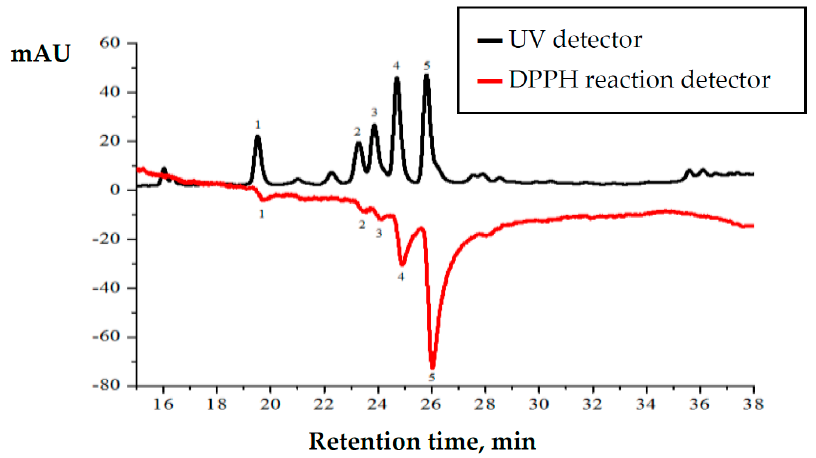
Figure 4. Chromatographic profile of Satureja hortensis L. raw material methanolic extract during the F2 phase. 1— trans -sinapic acid 19.44 min., 2— trans -p-coumaric acid 23.27 min., 3—hesperetin 23.83 min., 4—rutin 24.73 min., 5—rosmarinic acid 25.84 min.